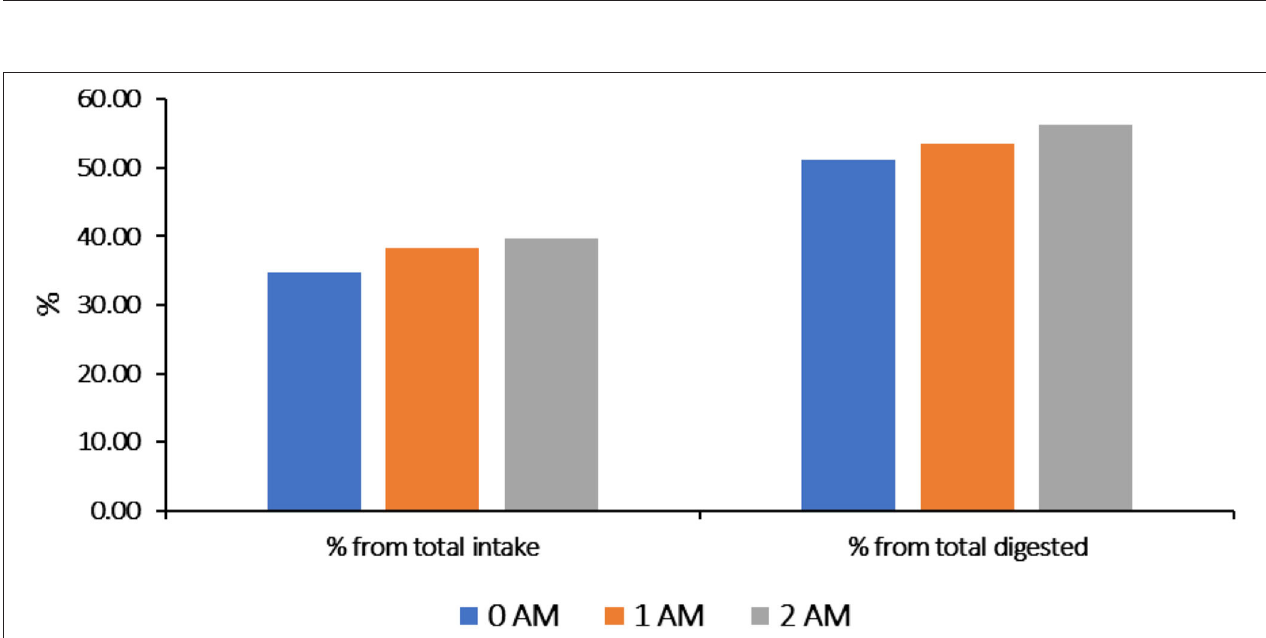
FIGURE 2 | Coefficients of nutrients digestibility. 0AM group: received the normal basal ration (Control group); 1AM group: received normal basal ration replacing sunflower cake with 300g of protein concentrate Agro-Matic until parturition and after parturition they received normal basal ration replacing Sunflower cake with 1kg of protein concentrate Agro-Matic until the end of lactation period. 2AM group: received normal basal ration replacing sunflower cake with 500g of protein concentrate Agro-Matic until parturition and after parturition they received normal basal ration replacing Sunflower cake with 1.5kg of protein concentrate Agro-Matic until the end of the lactation period. DM, dry matter; OM, organic matter; CP, crude protein; CF, crude fat; CF, crude fiber; NFE, nitrogen-free extract.